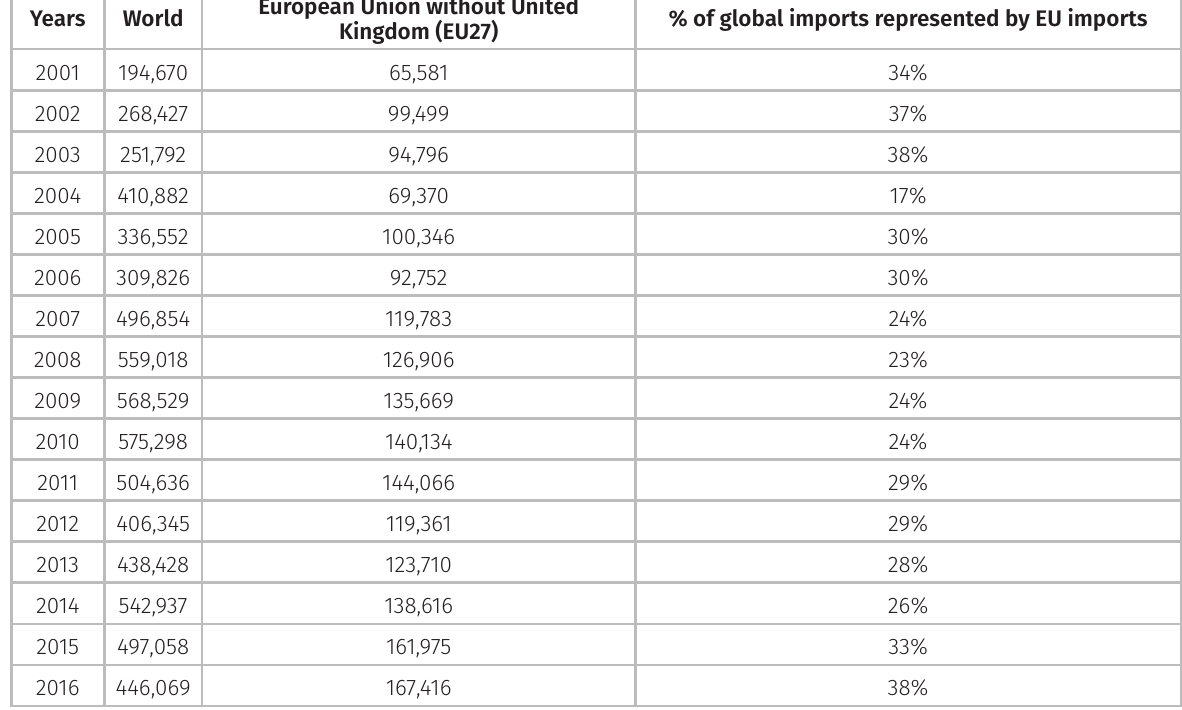
Source: Own elaboration using data obtained from Trade Map